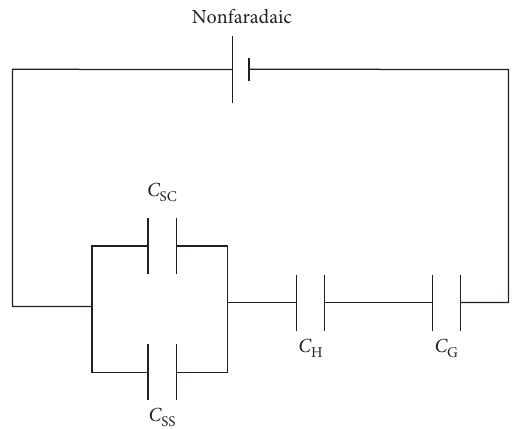
Figure 2: Schematic of the model that represents the potential difference across the electrolytic bulk for nonideal MO X